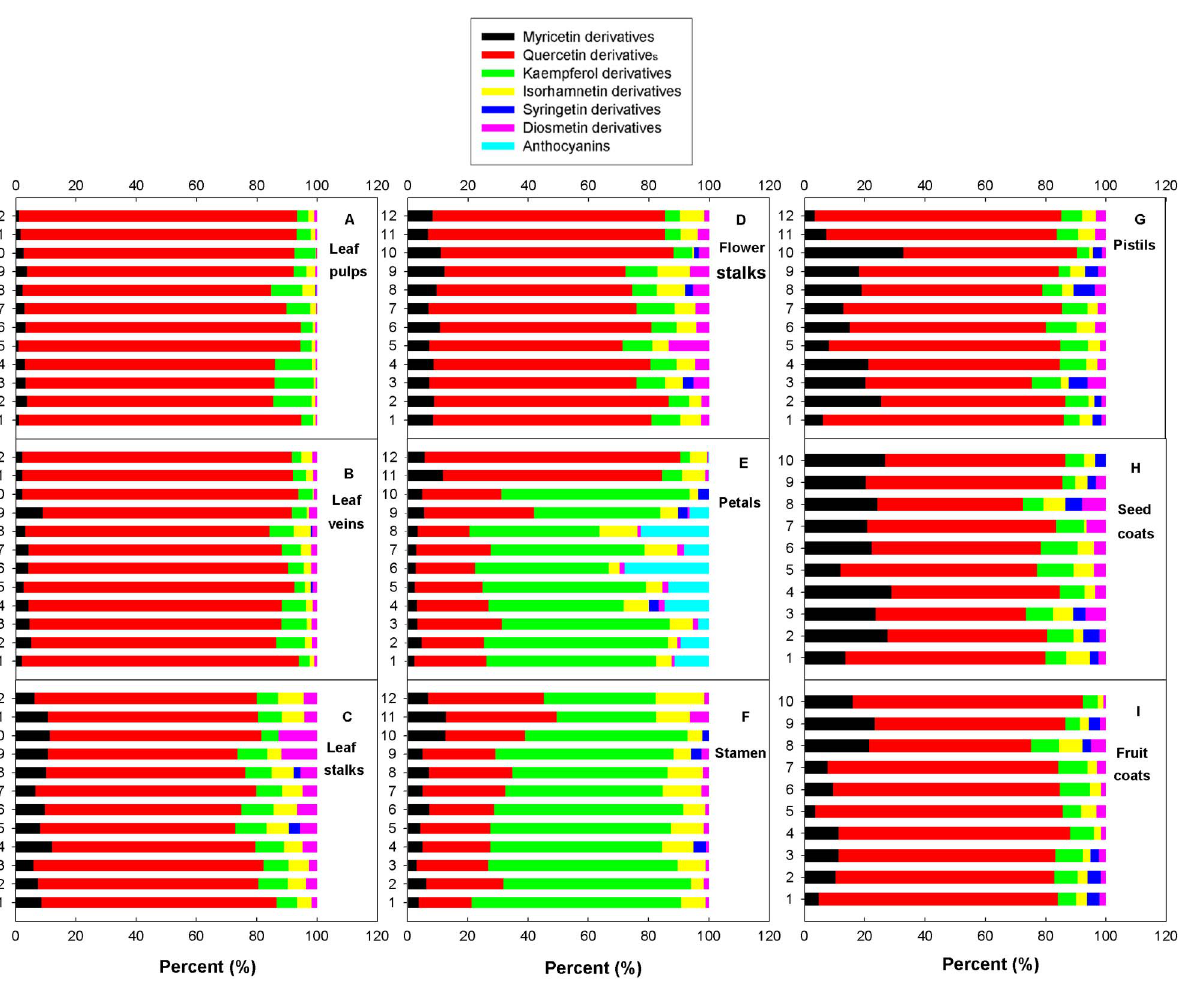
Figure 2. Percentages contributed by the group of flavonoid derivatives to total flavonoids in various tissues of the different genotypes. Cultivar designations (1–12; Y-axis) correspond to those in Table 1.